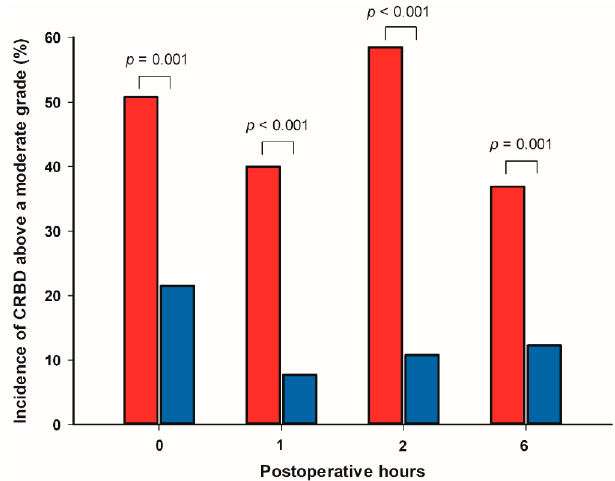
Figure 2. Comparisons of incidences of CRBD above a moderate grade between the control group (red bar) and ketorolac group (blue bar) at 0, 1, 2, and 6 h postoperatively. Each column indicates the incidence of CRBD above a moderate grade. CRBD = catheter-related bladder discomfort; Postoperative hour 0 = upon admission to the postanesthetic care unit.